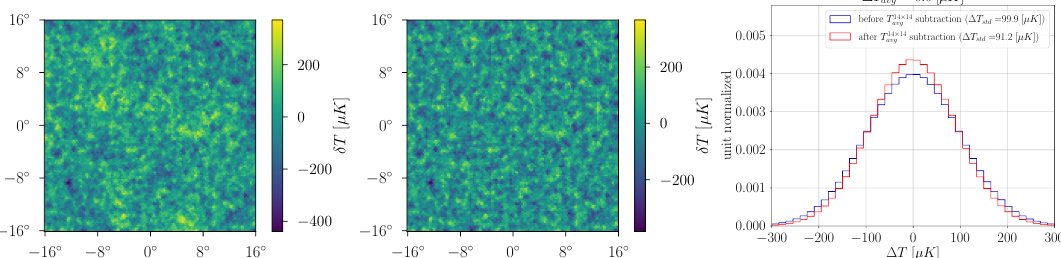
Figure 6 . A local patch of (upper-left) CMB within a region of longitude = [ − 16 ° , 16 ° ] and latitude = [ − 16 ° , 16 ° ] centered at ( θ, φ ) = ( π/ 2 , 0) and projected onto the Cartesian coordinates ( 140 × 140 pixels) using N = 256 . (middle) We subtract average temperatures T 14 × 14 side ( 14 × 14 pixels) of the patch. (right) The resulting unit-normalized ∆ T distributions of 10 3 CMB maps with and without T 14 × 14 avg